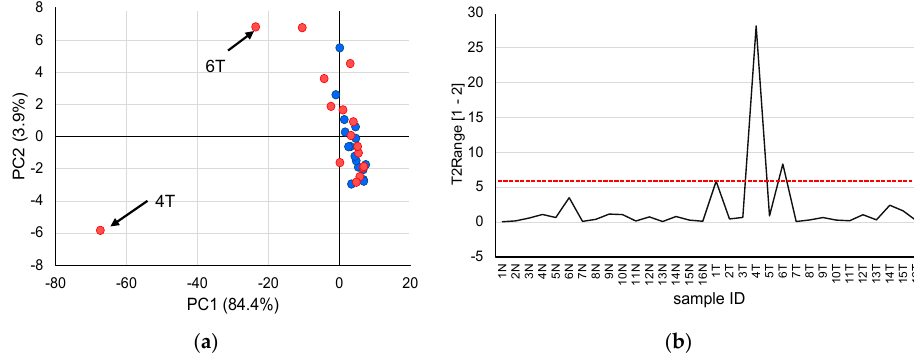
Figure 1. Outlier analysis based on quantified dipeptides obtained from patients with liver cancer. ( a ) principal component analysis score plots using the auto-scaled dipeptide data of paired non-tumor (blue) and tumor (red) tissues. The contribution ratios were 84.4% and 3.9% for PC1 and PC2, respectively. ( b ) Hotelling’s T 2 range plot of all samples. The red dashed line indicates the upper control limit ( α =